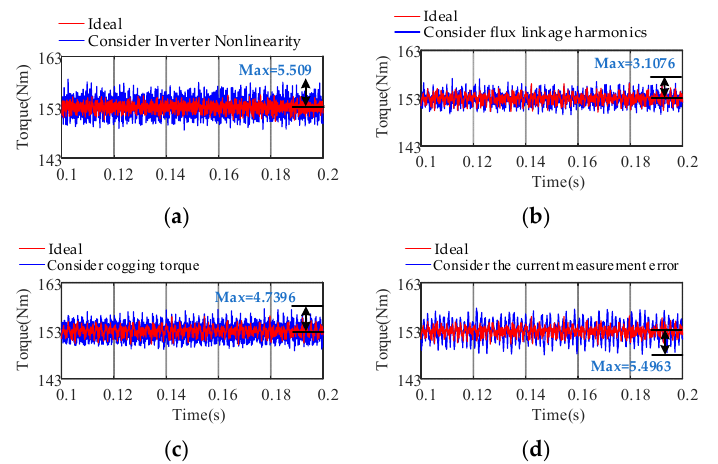
Figure 30. Comparison results of electromagnetic torque in the time domain: ( a ) comparison results of electromagnetic torque considering the inverter nonlinearity; ( b ) comparison results of electromagnetic torque considering the nonsinusoidal distribution of the air ‐ gap magnetic field; ( c ) comparison results of electromagnetic torque considering the cogging torque; ( d ) comparison results of electromagnetic torque considering the current measurement error.